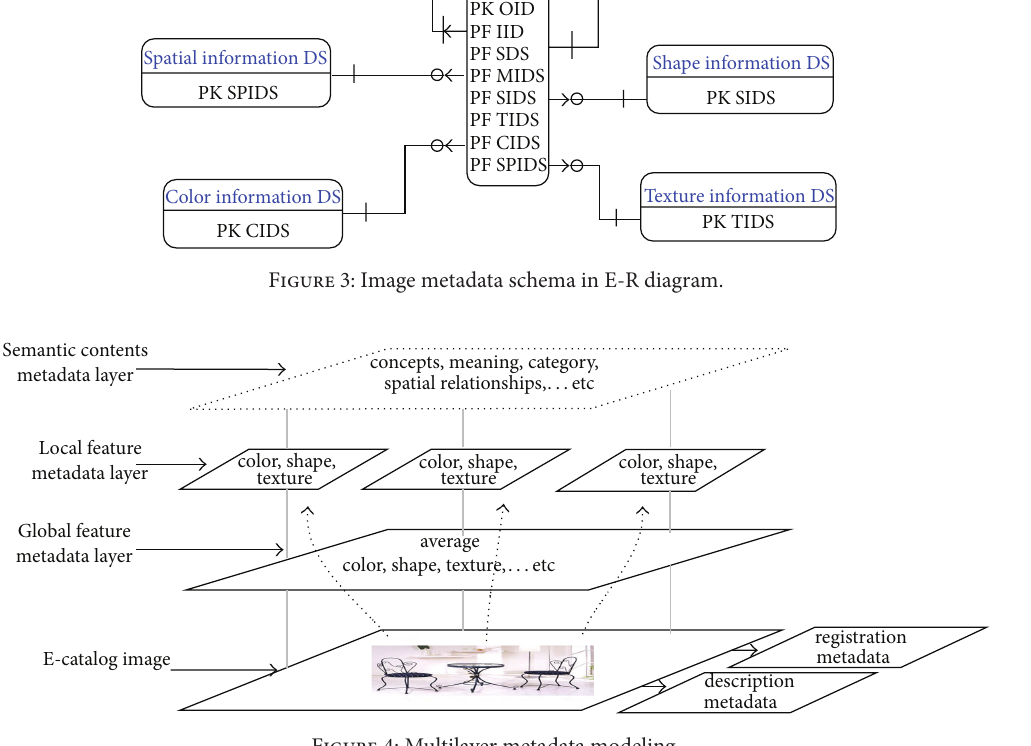
Figure 4: Multilayer metadata modeling.